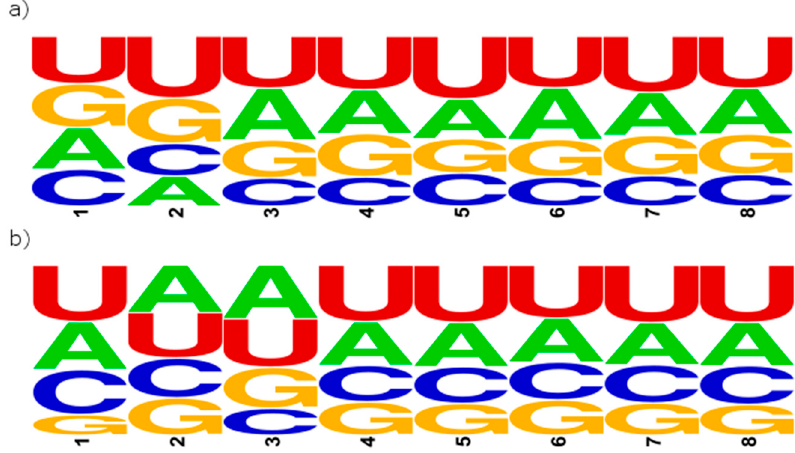
Figure 2. WebLogo 2.8.2 [28] diagram for sequences from the ( a ) VS8-5 ′ and ( b ) VS8-3 ′ subsets. Table 1. WebLogo 3.0 [28] results for vicinity sequences in the VS8-5 ′ subset. Position